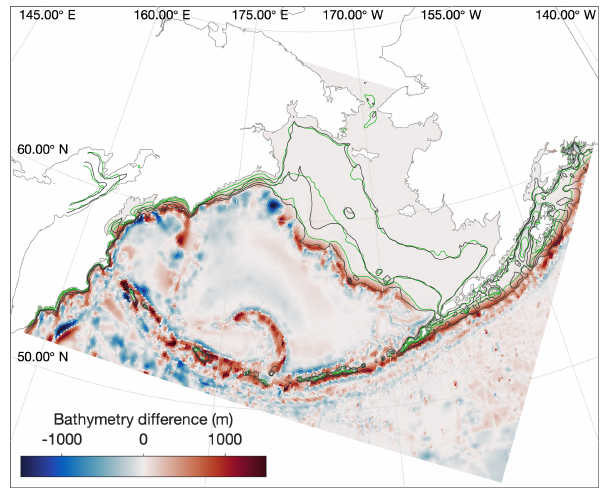
Figure 6. Difference in location between the real (black) and mod- eled (green) locations of the 50, 100, and 200m isobaths in the model domain. Colors indicate the adjustments to model bottom bathymetry (m) compared to the ETOPO5 dataset from which it was